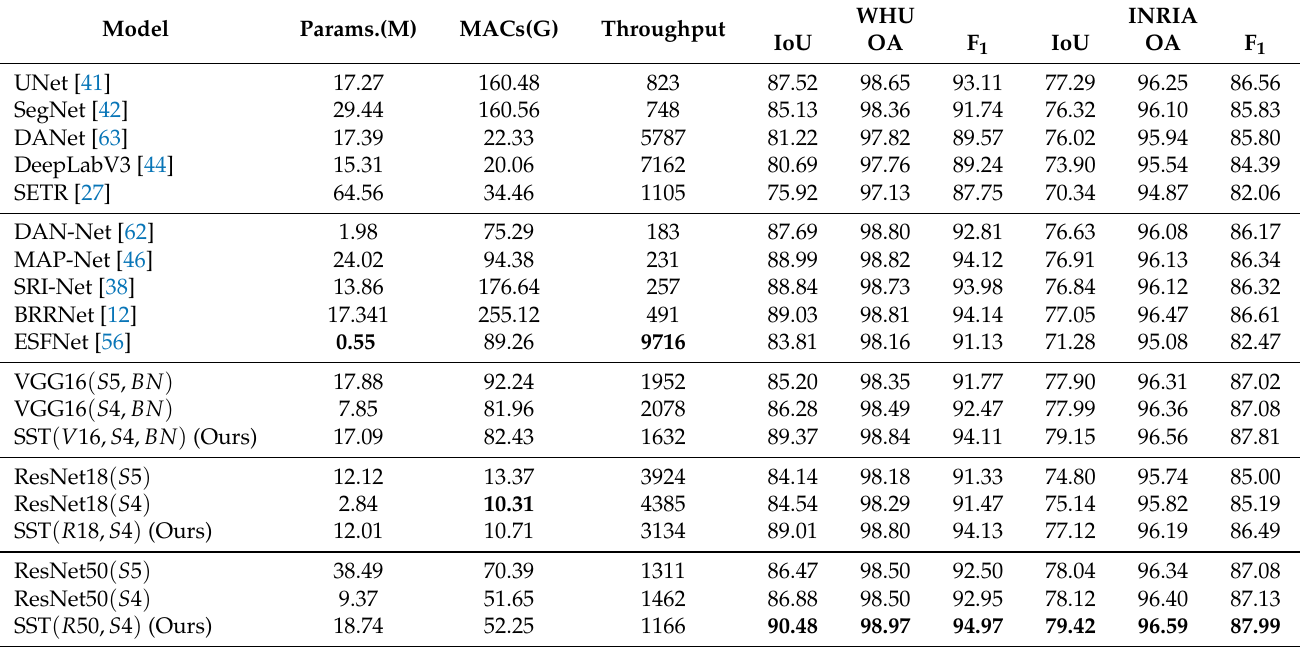
Table 9. Comparison with some well-known image labeling methods and state-of-the-art building extraction methods on the WHU and INRIA building datasets. UNet, SegNet, DANet, and DeepLabV3 are commonly used methods for segmentation tasks in CNN framework. SETR is a transformer-based method for segmentation. The methods mentioned in the second row are all based on the CNN framework for specific building extraction tasks. To validate the efficiency, we report number of parameters ( Params. ), multiply-accumulate operations ( MACs ) and images with 512 × 512 pixels per second on a 2080Ti GPU ( Throughput